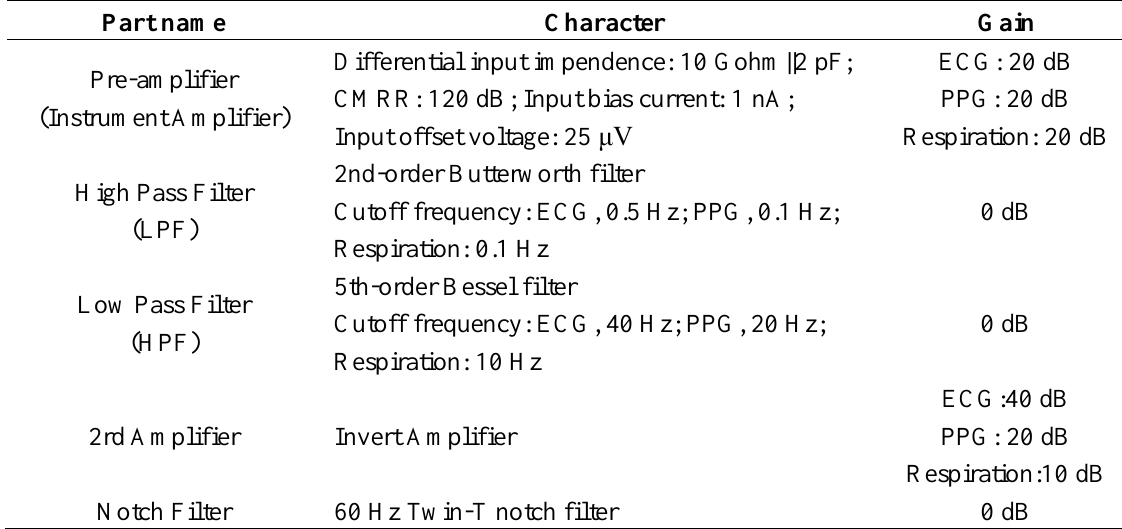
Table 1. Specifications of sensor’s amplifier and